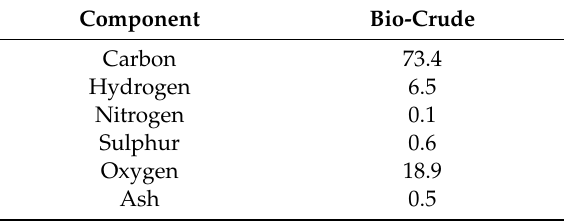
Table 3. Ultimate analysis of HTL bio-crude, adapted from Rowlands et al.